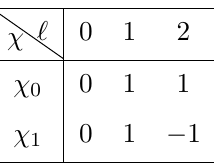
Table 1 . The coe(cid:14)cients of the second and third terms in equations (4.10).